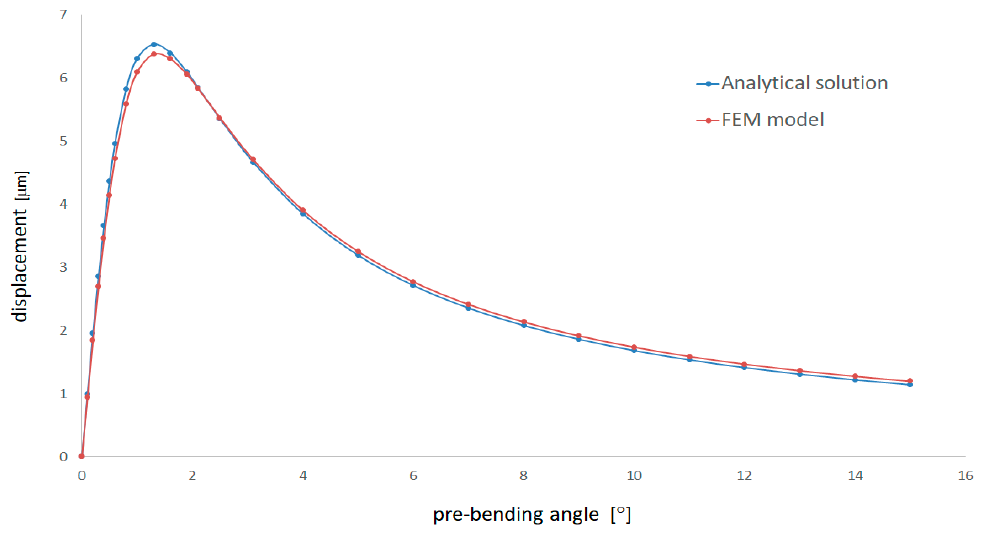
Figure 6. Pre-bending angle–displacement characteristics of the V-type actuator with straight